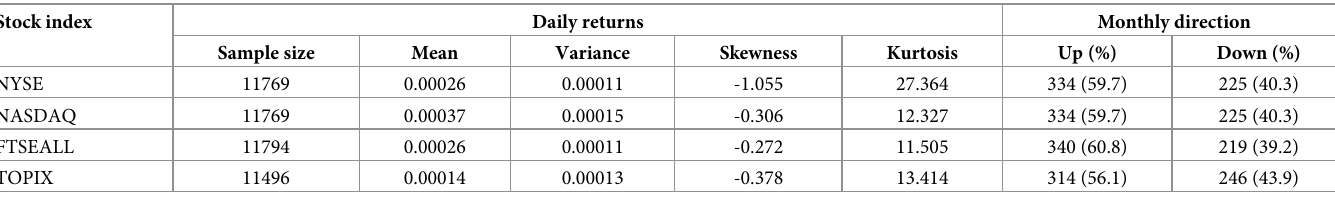
Fig 3. Daily log price and return time series of the NYSE, NASDAQ, FTSEALL, and TOPIX. https://doi.org/10.1371/journal.pone.0276322.g003 Table 1. Descriptive